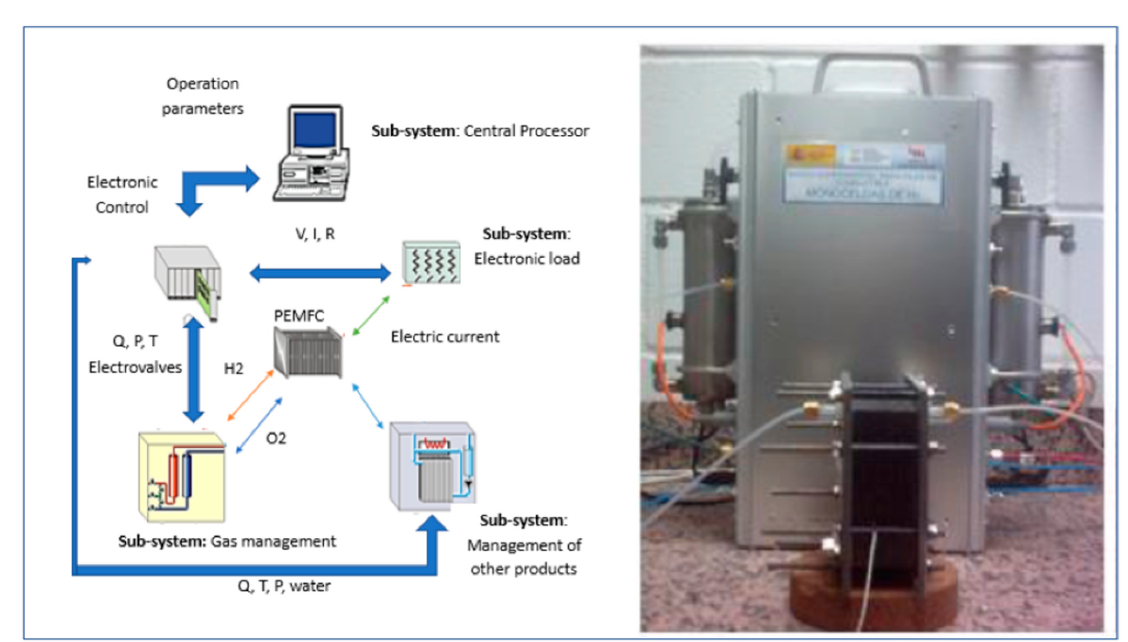
Figure 1. The experimental